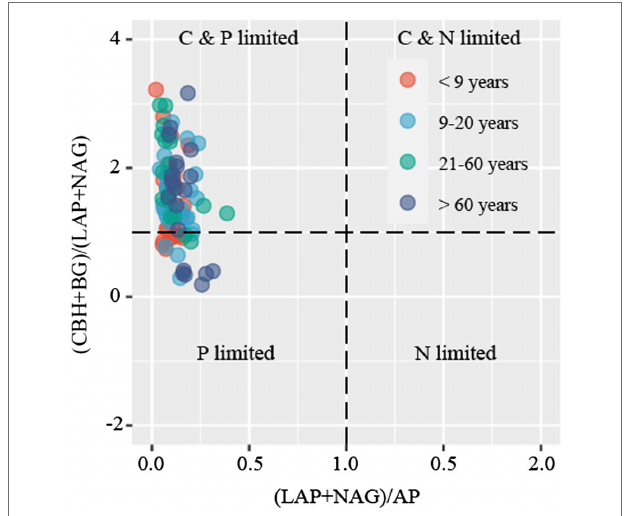
FIGURE 2 | Scatter plots of soil enzymatic stoichiometry for the studied sites. Dots with different colors represent different stand ages.